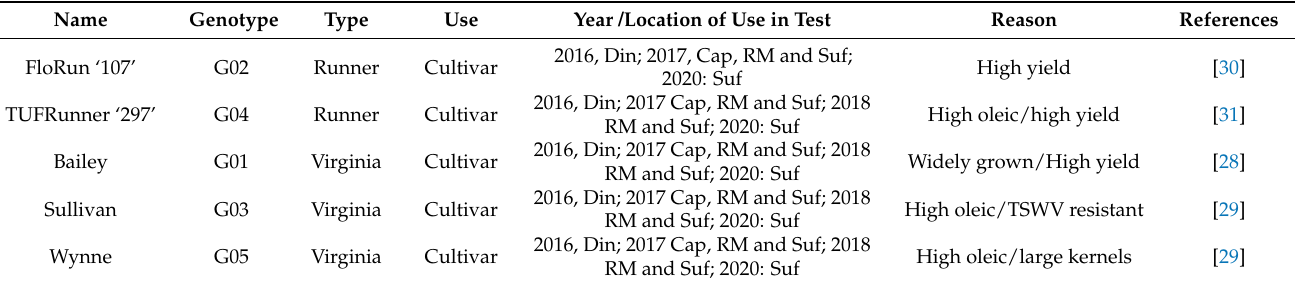
Table 1. Description of Virginia and runner cultivars tested from 2016 to 2020, and the reasons for inclusion in the